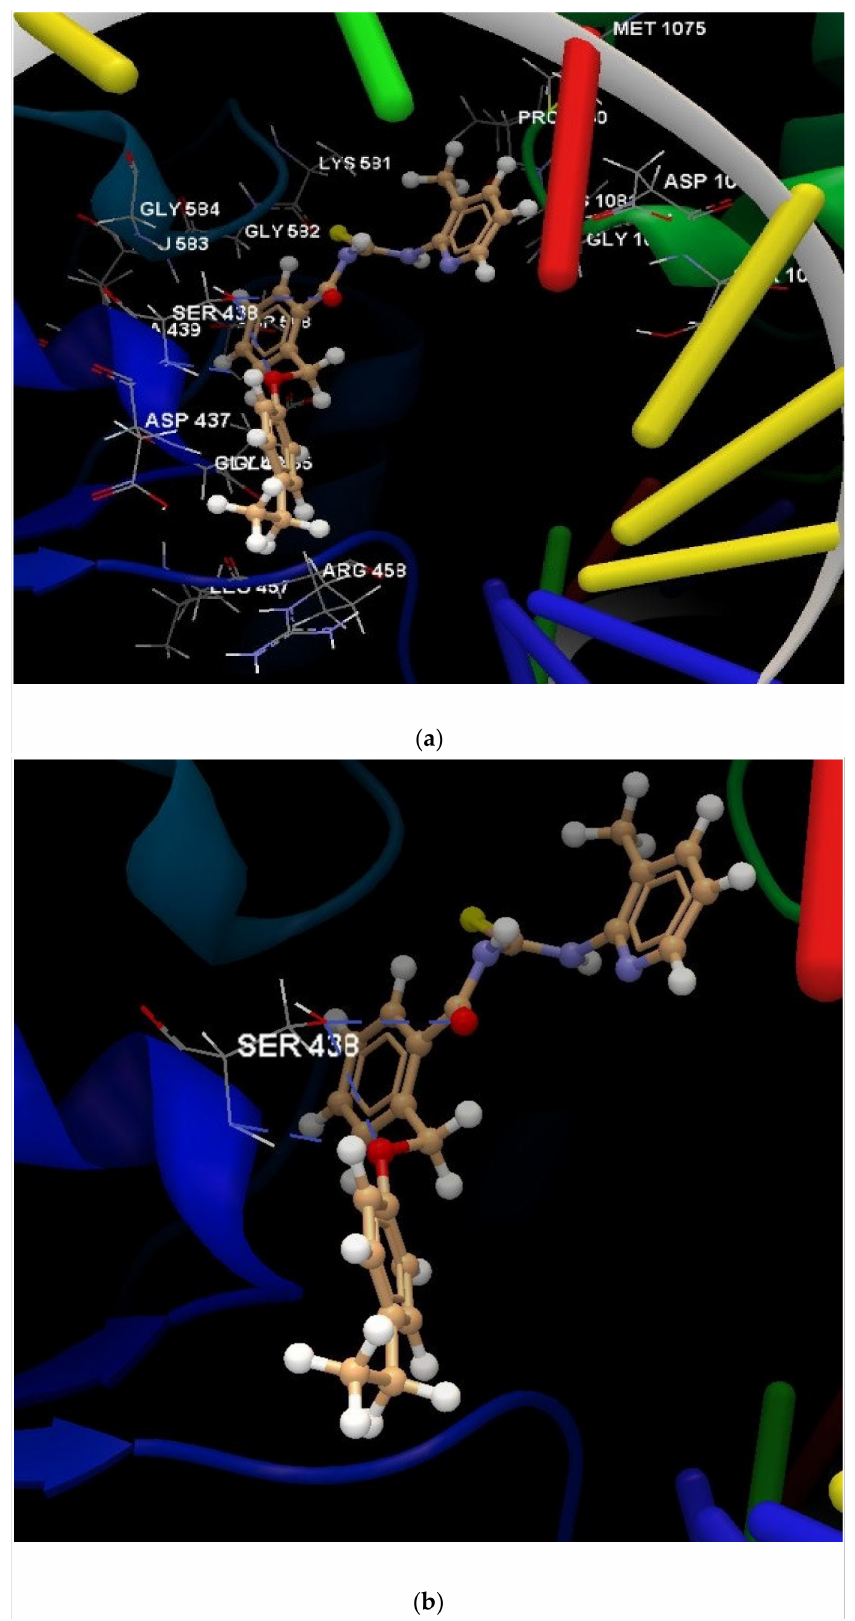
Figure 7. ( a ) The interaction group for ligand 1d , in the approach of predicting protein–ligand binding affinity. ( b ) Hydrogen bonds created between the ligand 1d and the amino acid SER 438 from the DNA gyrase subunit of S. aureus